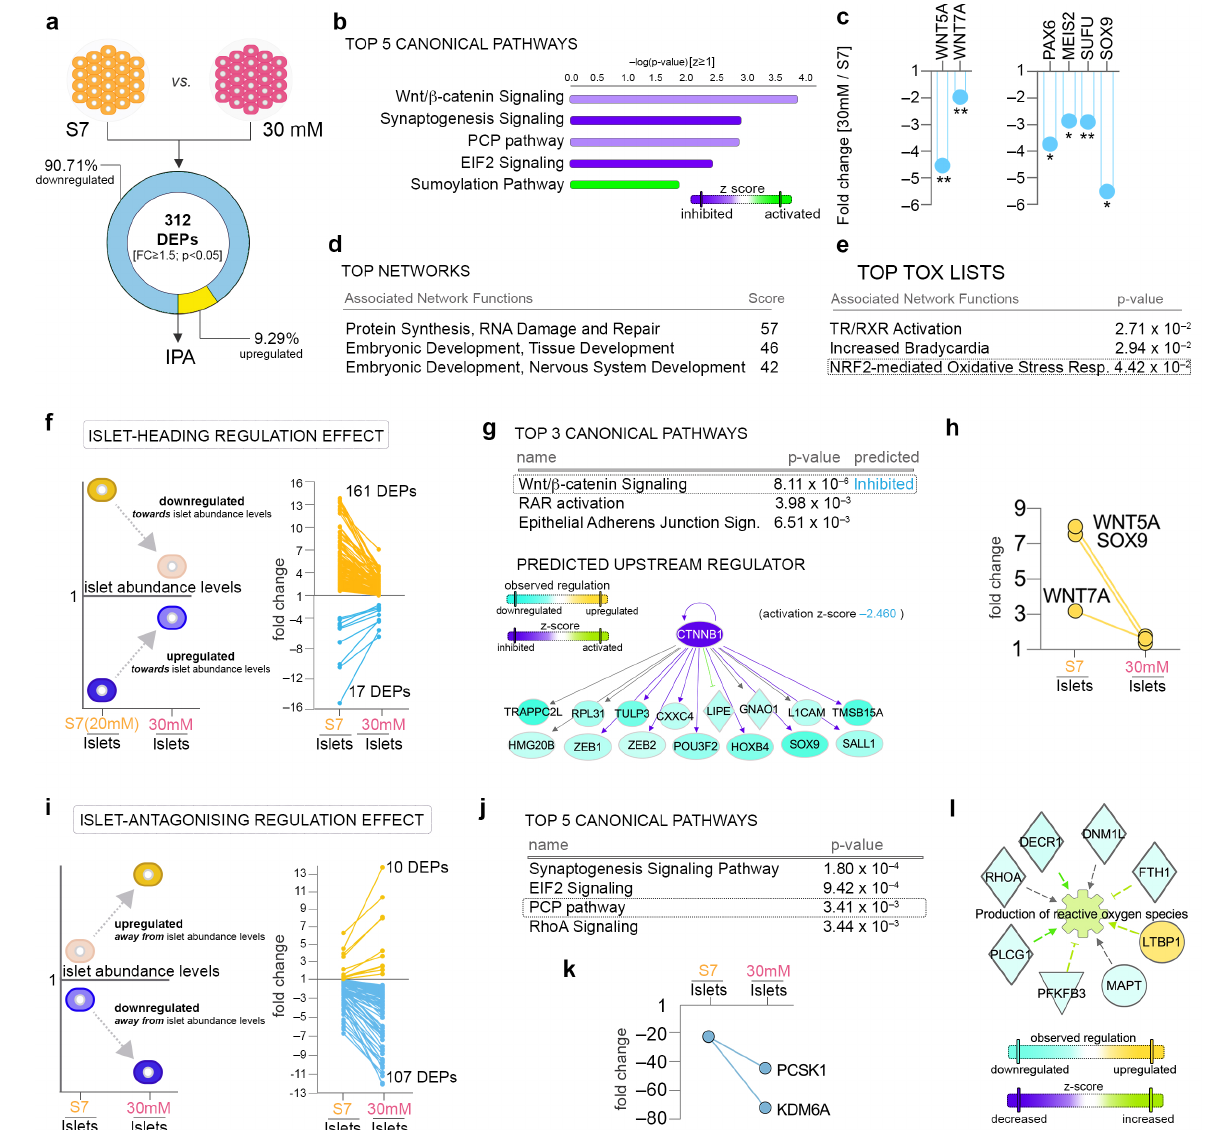
Figure 3. Pathway analysis of 30-mM glucose concentration effect. ( a ) Analysis workflow depicting the comparison employed. ( b ) Top canonical pathways with predicted regulation characterizing the 30-mM glucose condition. ( c ) Graphs of the observed downregulated WNT5A and WNT5B ligands and PAX6, MEIS2 (Meis homeobox 2), SUFU (suppressor of fused protein) and SOX9 (SRY-Box Transcription Factor 9) in the 30 mM glucose condition. ( d ) Top networks and ( e ) top tox list characterizing the proteome landscape of the 30 mM glucose condition. ( f ) Scheme depicting the selection strategy and number of proteins displaying a dynamic of regulations compatible with an islet-heading regulatory pattern in response to 30 mM glucose. ( g ) Top 3 canonical pathways and the network representation of one of the top predicted upstream regulators’ (Catenin Beta 1, CTNNB1) target molecules. ( h ) Graphs of WNT5A, WNT7A and SOX9 following an islet-heading regulation pattern. ( i ) Scheme depicting the selection strategy and number of proteins displaying a dynamic of regulations compatible with an islet-antagonizing regulatory pattern in response to 30 mM glucose. ( j ) Top 5 canonical pathways characterizing the subgroup of proteins displaying islet-antagonizing regulation. ( k ) Graphs of the β -cell markers PCSK1 and KDM6A (Lysine Demethylase 6A) presenting an islet-antagonizing regulation pattern. ( l ) IPA-generated network representations of selected dataset differentially expressed proteins (DEPs) characterizing the corresponding top disease and function processes. * p < 0.05, ** p <